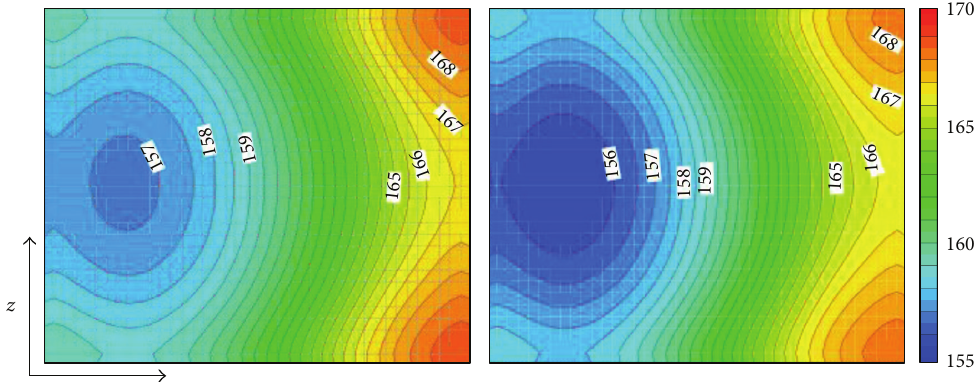
Figure 9: Surface temperature distributions for the dimple (left) and protrusion (right) configurations shown in Figure 8, as investigated by Sund´en et al. [10].